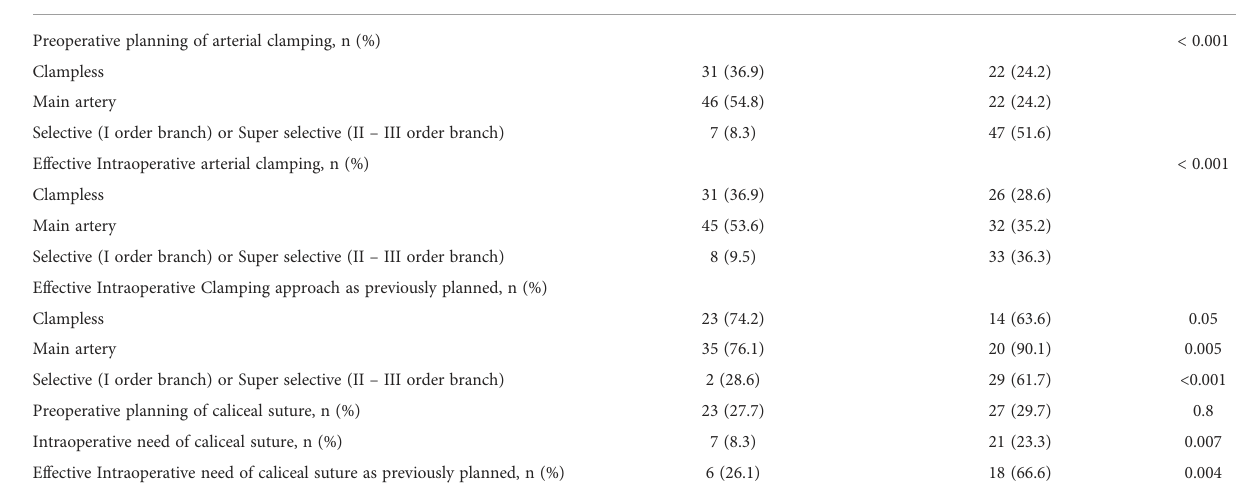
TABLE 2 Sub-analysis in patients underwent PN (n= 175) to compare the preoperative planning and the intraoperative approach to the renal hilum and caliceal system suturing.